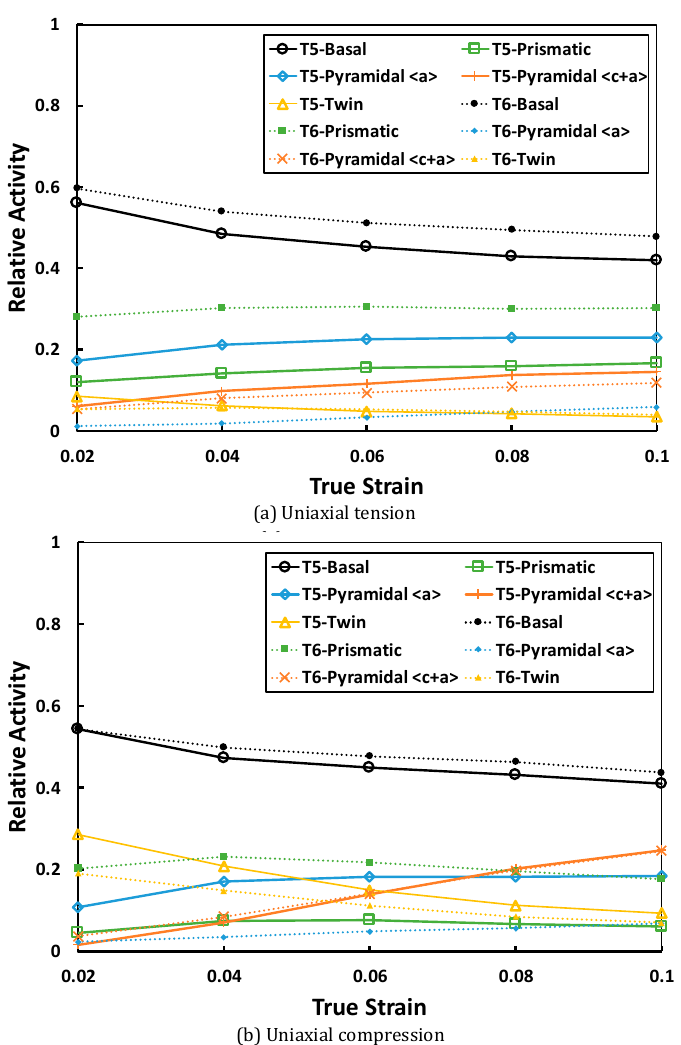
Figure 25. The strain maps obtained by the SEM ‐ DIC experiment compared to the CPFE predic ‐ tion in WE ‐ 43 T6 sample during uniaxial tension at different strain values: ( a ) 𝜀 (cid:3404) 0.76% (SEM ‐ DIC), ( b ) 𝜀 (cid:3404) 0.76% (Simulation), ( c ) 𝜀 (cid:3404) 4.83% (SEM ‐ DIC), ( d ) 𝜀 (cid:3404) 4.83% (Simulation), ( e ) 𝜀 (cid:3404) 8.15% (SEM ‐ DIC), ( f ) 𝜀 (cid:3404) 8.15% (Simulation) (After Ganesan et al. [8]).